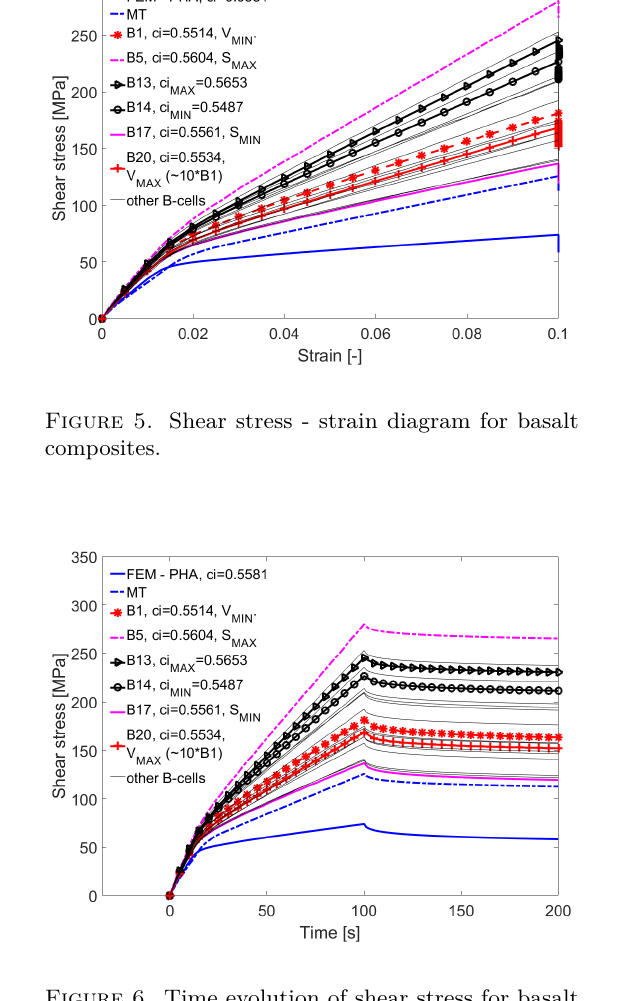
Figure 6. Time evolution of shear stress for basalt composites.